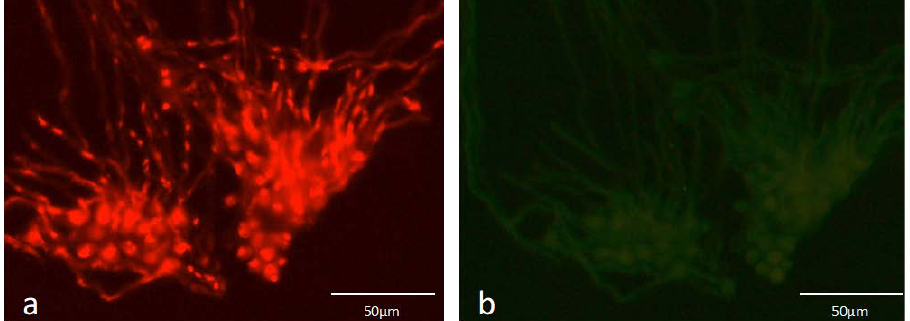
Figure 1. Epifluorescence microscope visualization of A. fumigatus ATCC 46645 after overnight growth for germination, in peptone-yeast extract-glucose (PYG) medium with FUM274 ( a ). Visualization of the same microscopic field at the green channel (negative control of FUM274) ( b ). Images were obtained with equal exposure times.